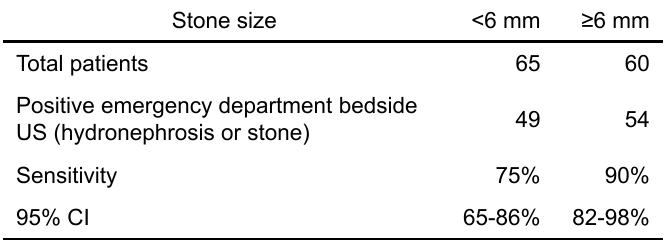
Table 3. Sensitivity of ultrasound (US) by stone size.